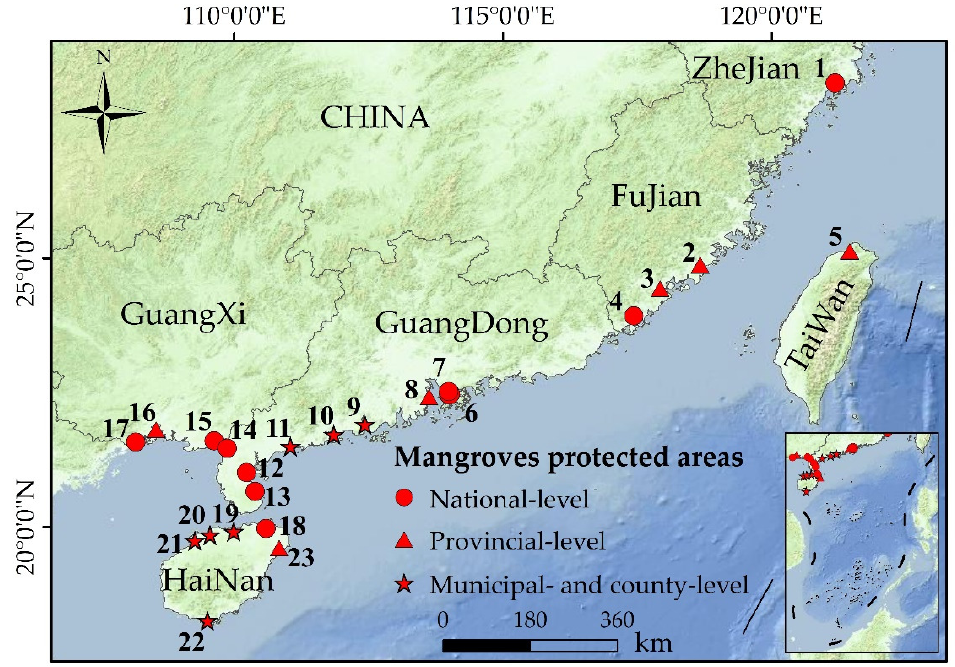
Figure 1. Location of the study area and the spatial distribution of the selected mangrove reserves. (The details of the reserve corresponding to the number are shown in Table 1.) Table 1. The detailed information of the selected reserves in this